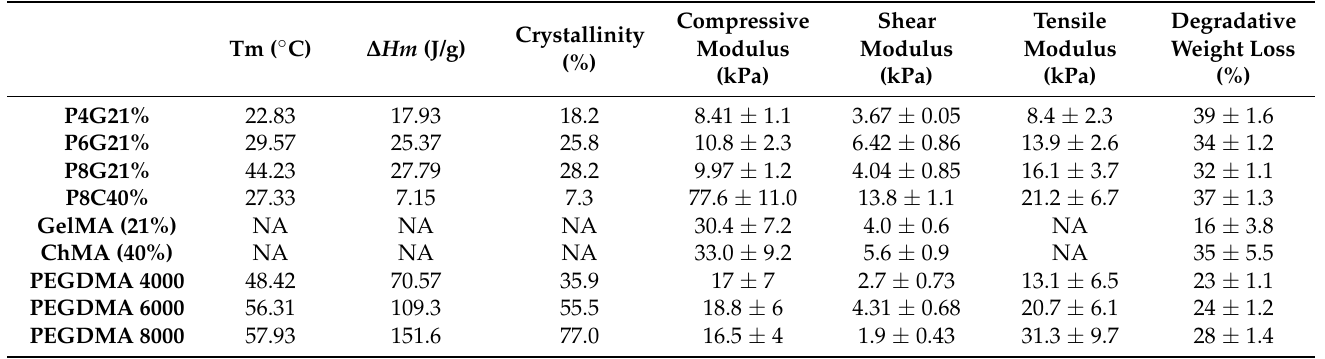
Table 3. Characterization of the crosslinked DN